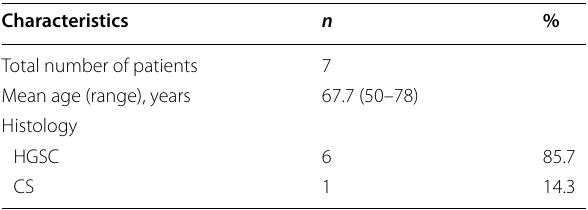
Table 3 Characteristics of patients after neoadjuvant chemotherapy